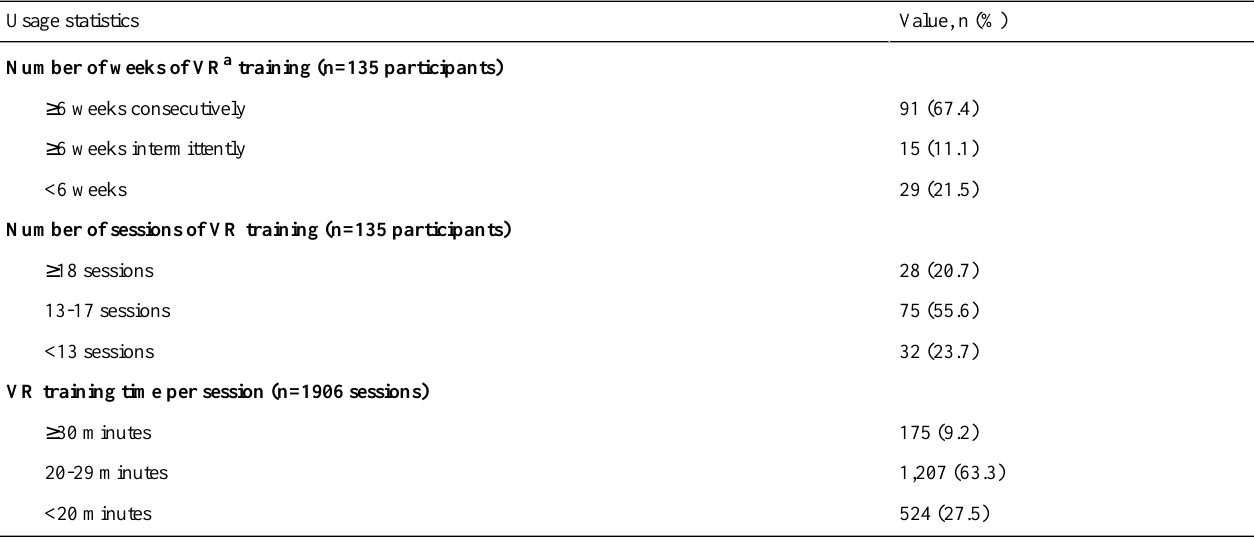
Table 4. Usage statistics of virtual reality training.